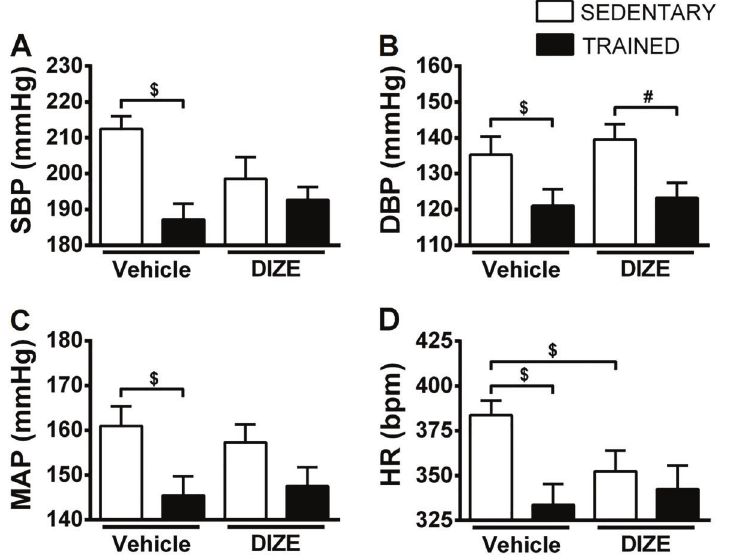
Figure 1. Means ± SE of systolic blood pressure (SBP; A ), diastolic blood pressure (DBP; B ), mean arterial pressure (MAP; C ) and heart rate (HR; D ) of non-anesthetized sedentary spontaneously hyper- tensive rats (SHRs) that received intragastric administration of vehicle or diminazene aceturate (DIZE; 1 mg/kg) and trained SHRs that received intragastric administration of vehicle or DIZE. #,$ P o 0.005 (ANOVA followed by the Fisher LSD post hoc